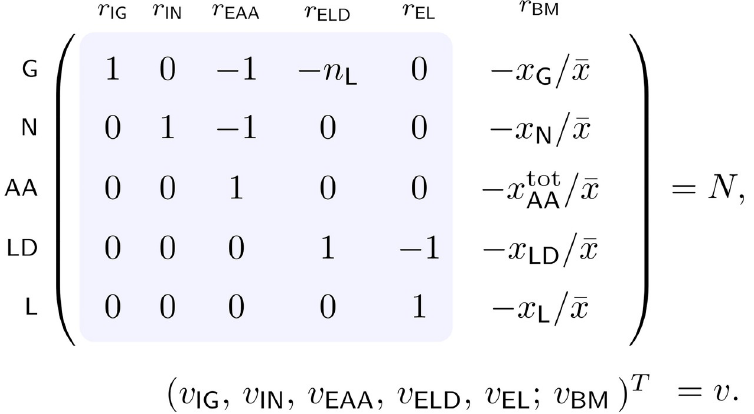
Fig 8. The stoichiometric matrix and the flux vector for a traditional model of the running example. The matrix consists of the metabolic part (shaded in blue, cf. Fig 1) and the biomass composition (last column). Scaling with the concentration � x is required to obtain dimensionless